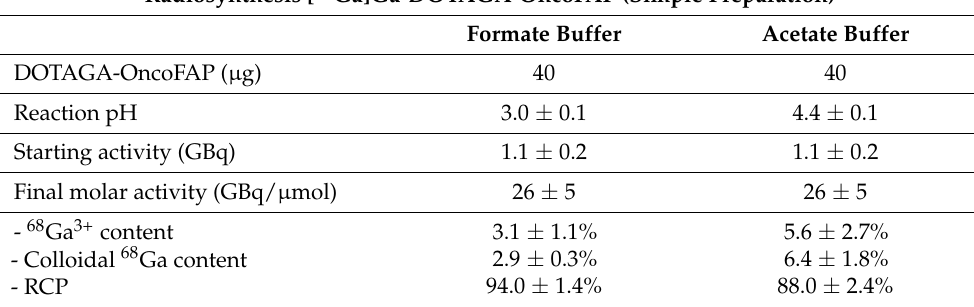
Table 6. Average value obtained for the synthesis of [ 68 Ga]Ga-DOTAGA-OncoFAP. Radiosynthesis [ 68 Ga]Ga-DOTAGA-OncoFAP (Simple Preparation)